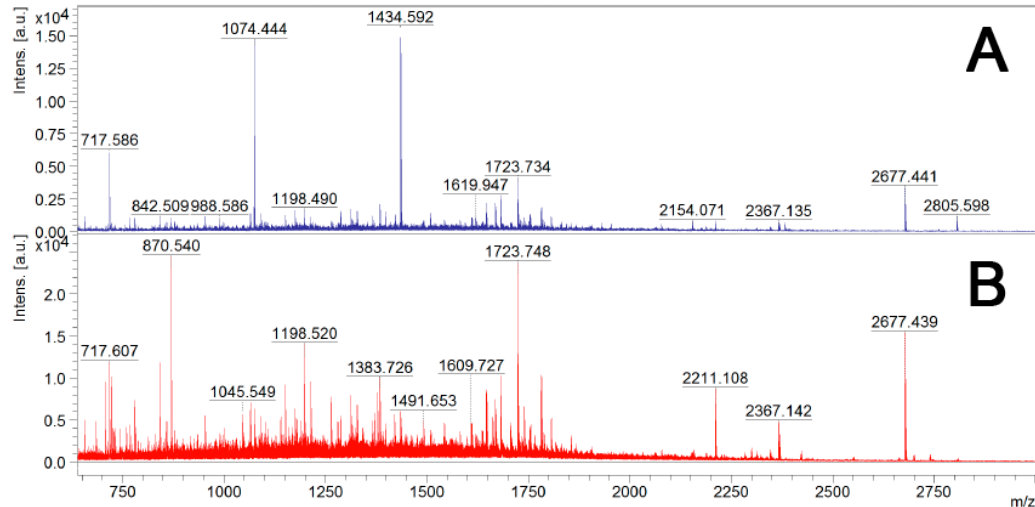
Figure 3. Mass spectra from MALDI-TOF MS of trypsin-digested samples of live B. cenocepacia J2315 cells. Sample A —Single trypsin digestion: 2.5 μ g/mL of trypsin in PBS for 10 min at 37 °C; Sample